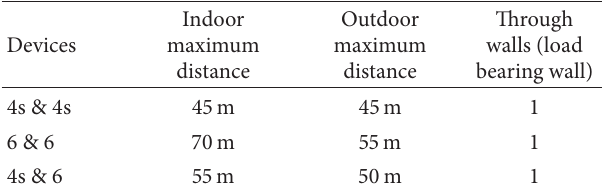
Table 3: The tested maximum connection distance and through- walls